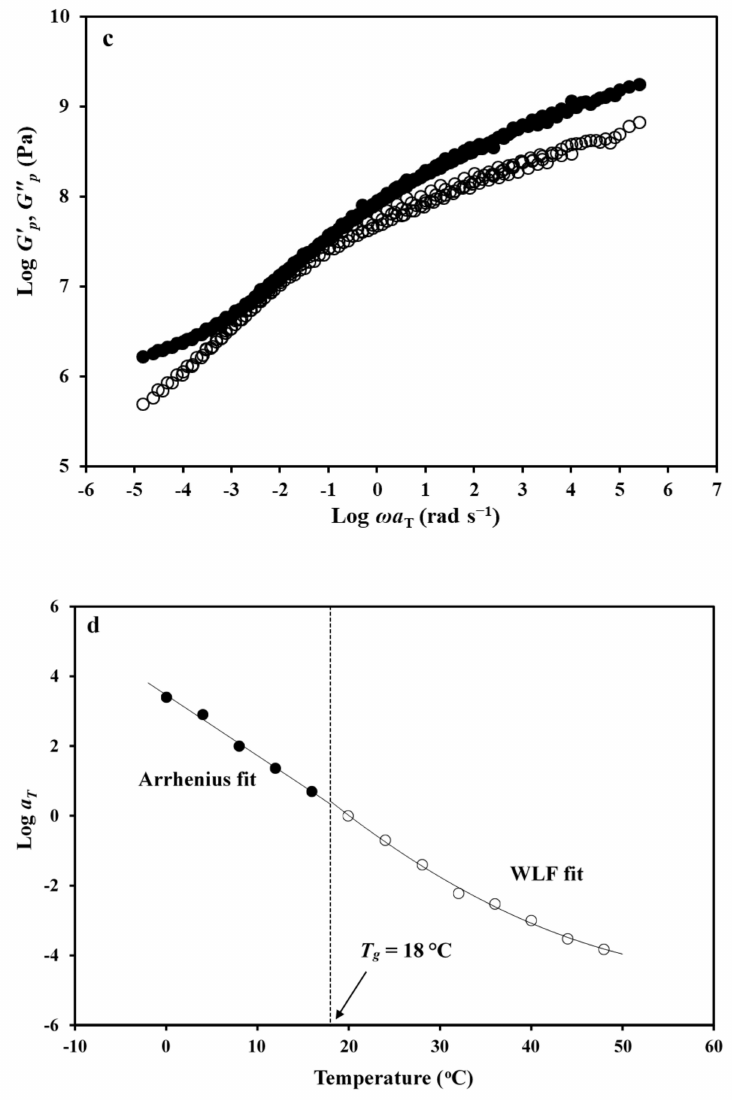
Figure 5. Frequency variation of a G' and b G" for the HPMC-AAc network (1:5); bottom curve is taken at 48 °C ( □ ), other curves successively upward, 44 °C ( ◊ ), 40 °C ( ∆ ), 36 °C ( ), 32 °C ( ), 28 °C ( - ), 24 °C (–), 20 °C ( ○ ), 16 °C (+), 12 °C ( ■ ), 8 °C ( ♦ ), 4 °C ( ▲ ), 0 °C ( ● ), respectively, c G' p ( ● ) and G" p ( ○ ) values reduced to 20 °C and plotted logarithmically against reduced frequency ( ω a T ) utilis- ing the mechanical spectra in Figs. 5 a and 5 b , and d logarithm of the shift factor, α T , plotted against temperature from the data of the master curve in Figure 5 c .